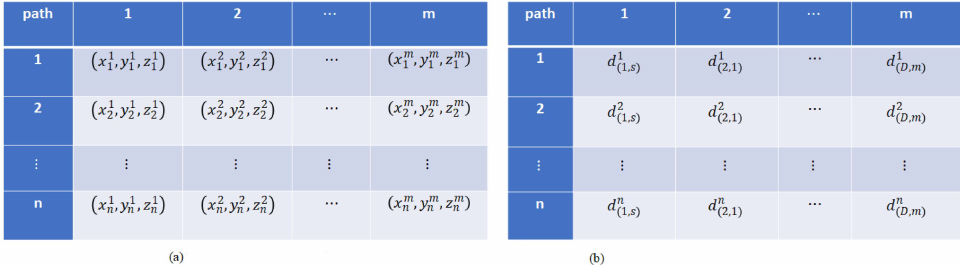
Figure 5. The working mechanism of the method. ( a ) The position matrix of each path; ( b ) the search space that represents distance between tuples.